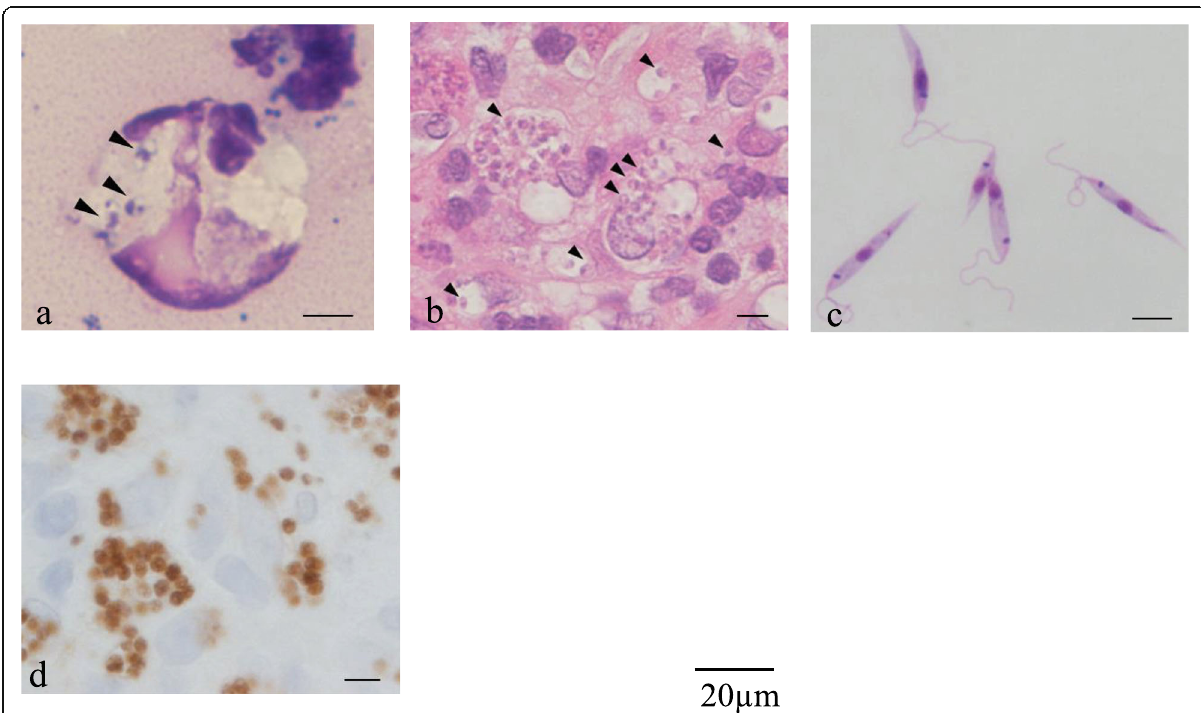
Fig. 2 Appearance of the lesions on histology. Giemsa staining ( a ) and hematoxylin and eosin staining ( b ) of punch biopsy specimens show Leishmania amastigotes (arrowheads). Giemsa staining of the skin tissue culture shows Leishmania promastigotes ( c ). C11C antibody-positive cells in the patient ’ s skin lesion ( d ). All bars are 5 μ m